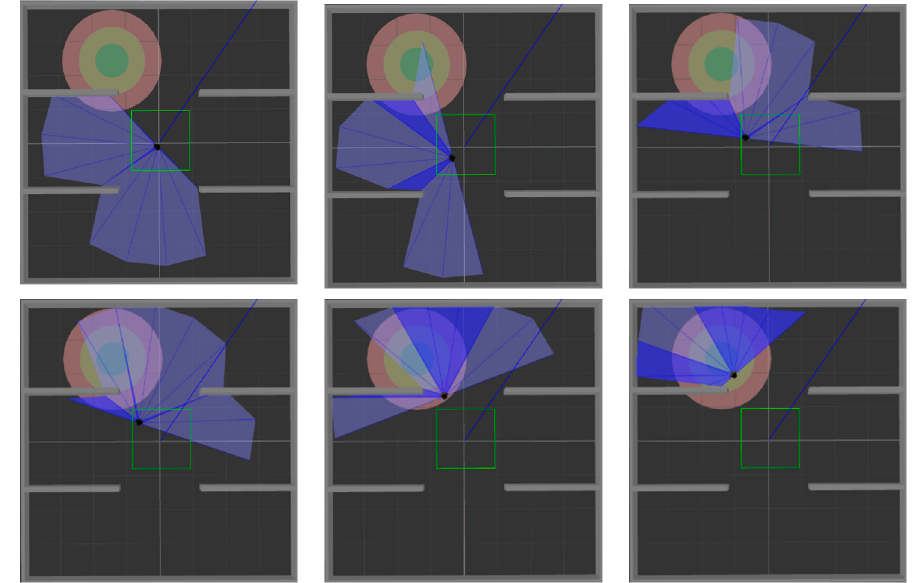
Figure 12. The motion process of the mobile robot in simulation Figure 6b.